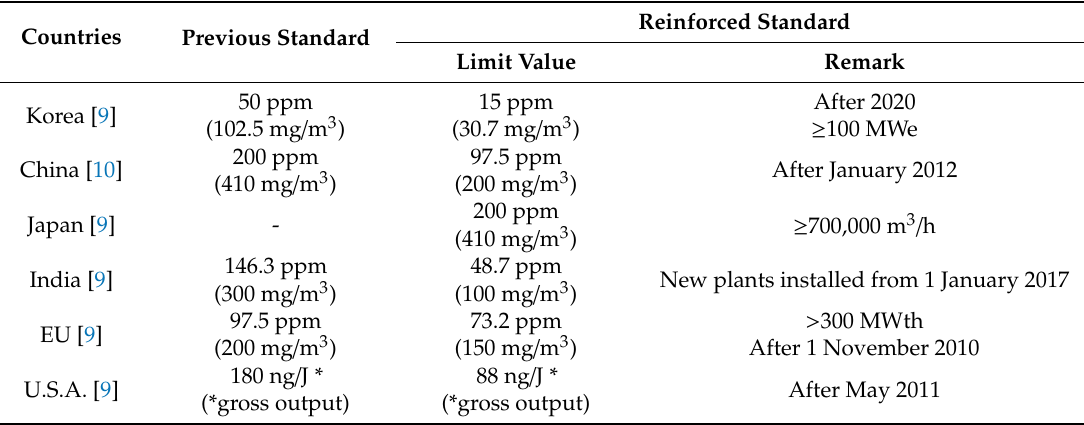
Table 1. Reinforced emissions standards for NO x from power plants in Korea compared with other countries. (* The ppm limits have been converted into mg / m 3 under the assumption that 1 ppm